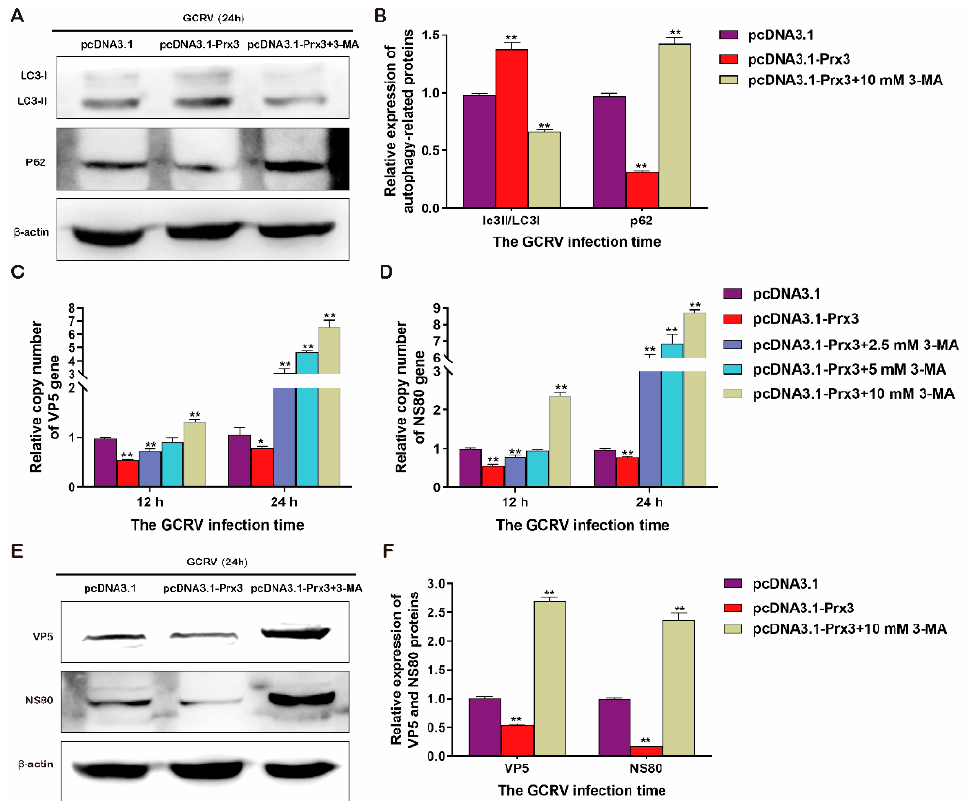
Figure 11. CiPrx3 enhanced autophagy to defend against GCRV. ( A ) The enhanced autophagy level induced by CiPrx3 was blocked by 3-MA. Cells were transfected with pcDNA3.1 or pcDNA3.1- CiPrx3 and treated with 3-MA, then were infected with GCRV and harvested at 24 h post-infection. Protein expression levels of LC3-II/LC3-I and P62 were detected by Western blotting. ( B ) The calculated protein expression levels of LC3-II/LC3-I and P62 at 24 h post-infection. ( C , D ) Relative mRNA expression of VP5 ( C ) and NS80 ( D ) in GCO cells. Cells were transfected with pcDNA3.1 or pcDNA3.1- CiPrx3 and treated with different concentrations of 3-MA, then were infected with GCRV and harvested at different time points post-infection for RT-qPCR analysis. ( E ) The inhibition of GCRV replication by CiPrx3 was blocked by 3-MA. Cells were transfected with pcDNA3.1 or pcDNA3.1- CiPrx3 and treated with 3-MA, then were infected with GCRV and harvested at 24 h post-infection. Protein expression levels of VP5 and NS80 were detected by Western blotting. ( F ) The calculated protein expression levels of VP5 and NS80 at 24 h post-infection. Data were shown as the mean ± SD ( n = 3). Asterisks represent significant differences (* = p ≤ 0.05, ** = p ≤ 0.01).